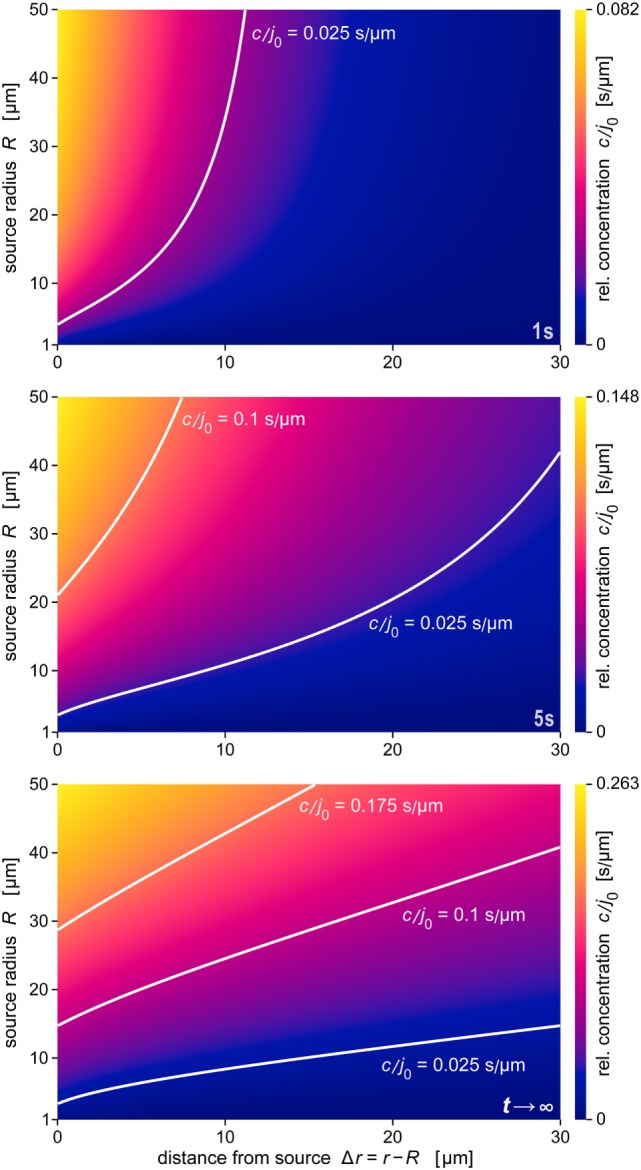
Density maps of the relative concentration c/j0 as a function of Δr and R. These maps were obtained at the three time points t = 1 s, t = 5 s, and t →∞ (steady state), respectively. Included are example contour lines of constant concentration (white curves). Note that the color scales of the three maps (shown at the right) are not the same. The data of all panels were evaluated using the parameter values D = 130 μm2 s−1 and k = 1.1 × 10−2 s−1 typical for C5a.